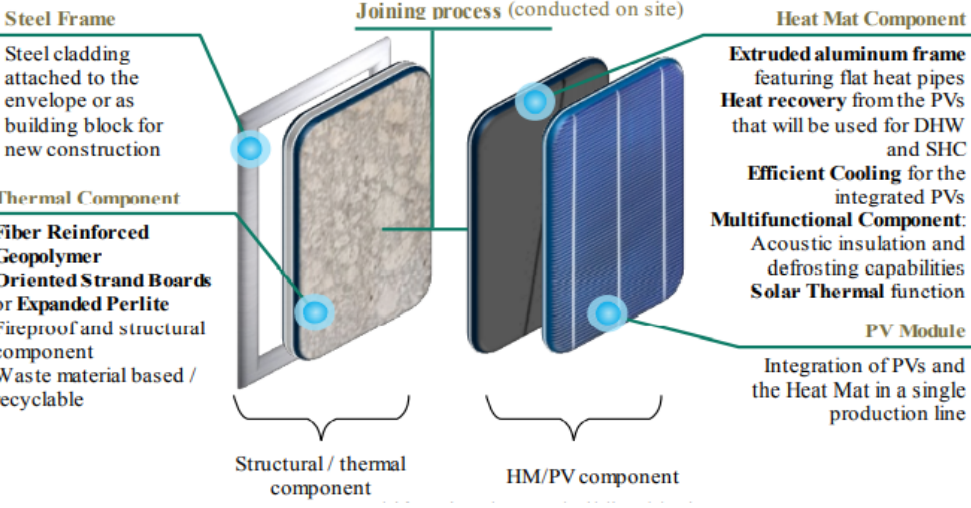
Figure 1. Multifunctional BIPVT building block, which will be developed in the framework of the PVadapt H2020